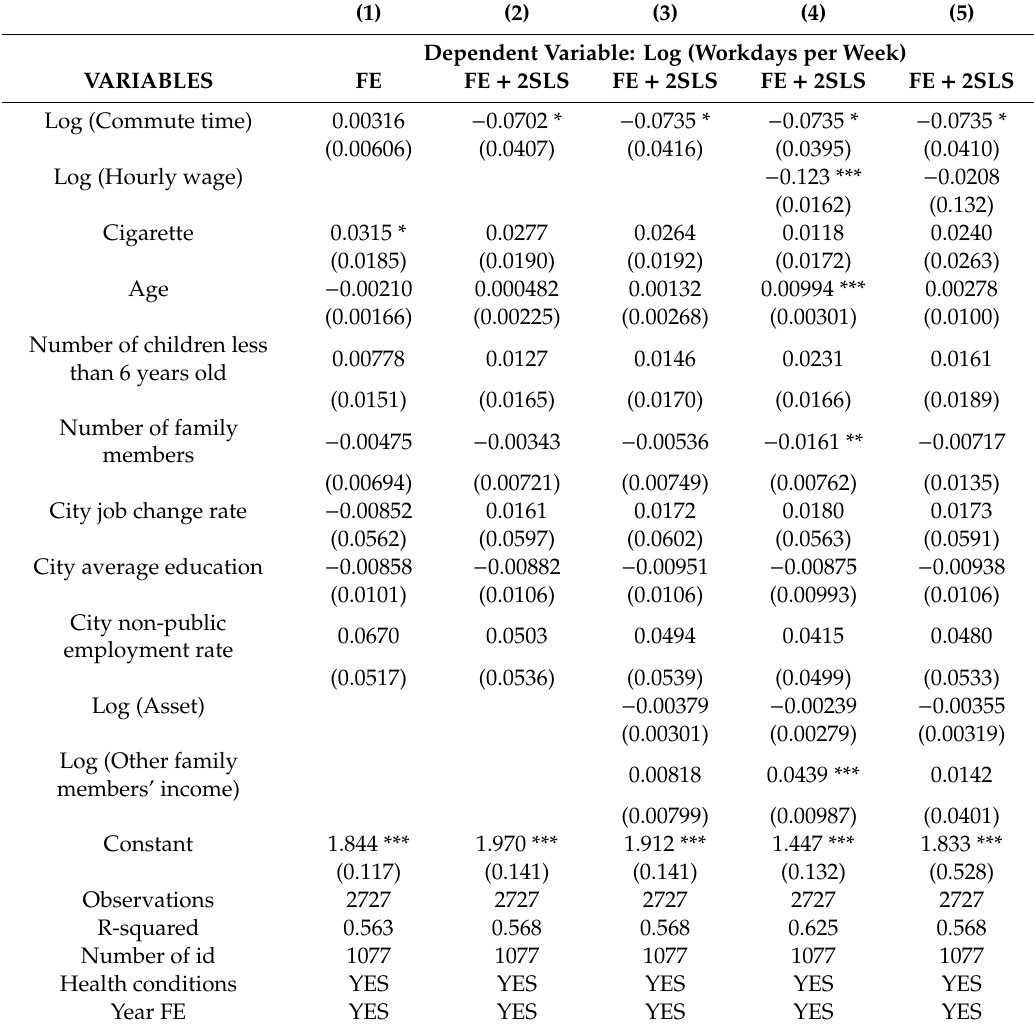
Table 5. E ff ect of commute time on labor supply—workdays per